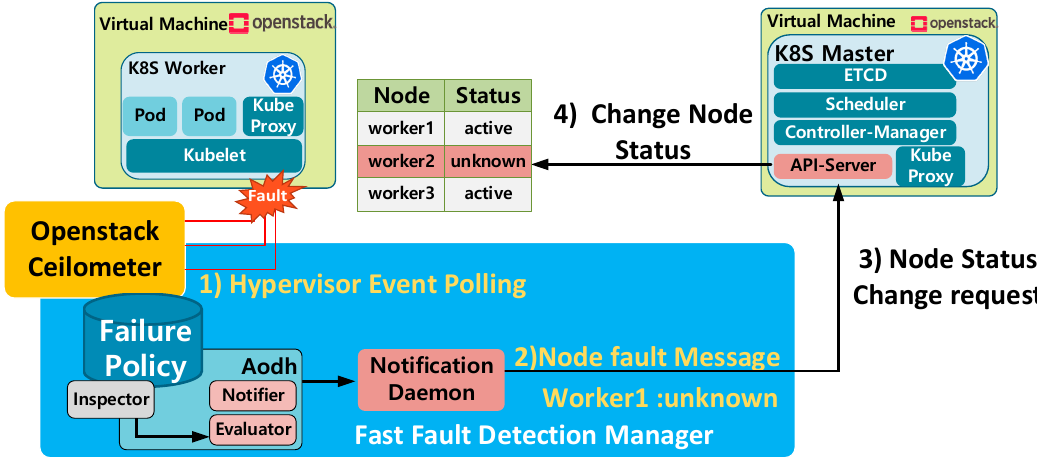
Figure 3. Fast-fault-detection manager.